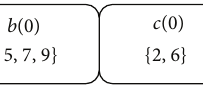
Figure 4: The oneItemList for Table